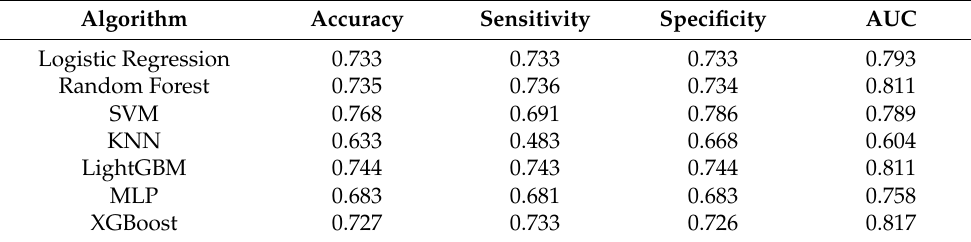
Table 2. Testing results of the predictive models for